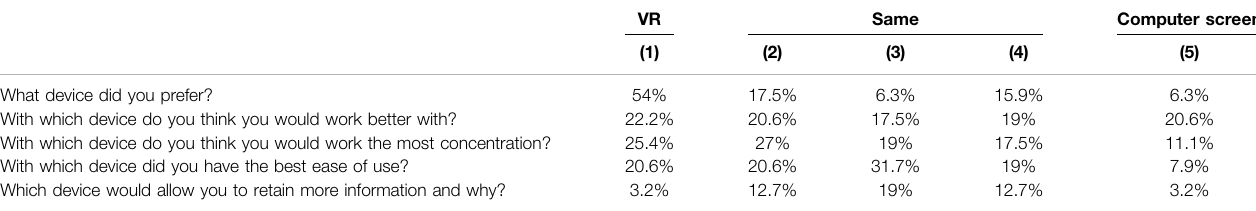
TABLE 4 | Device preferences.